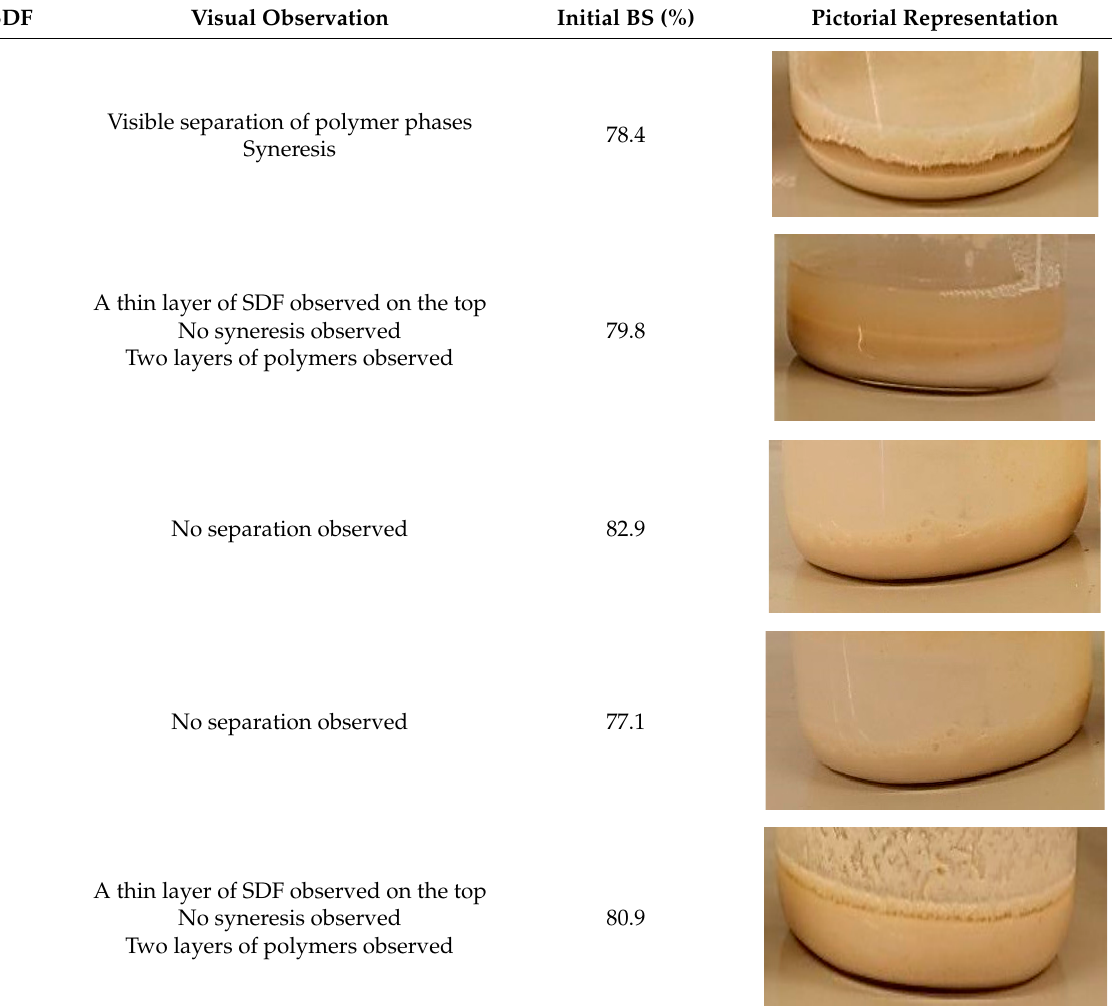
Table 1. Visual representation of phase separation between BGNS and BGN-SDF.